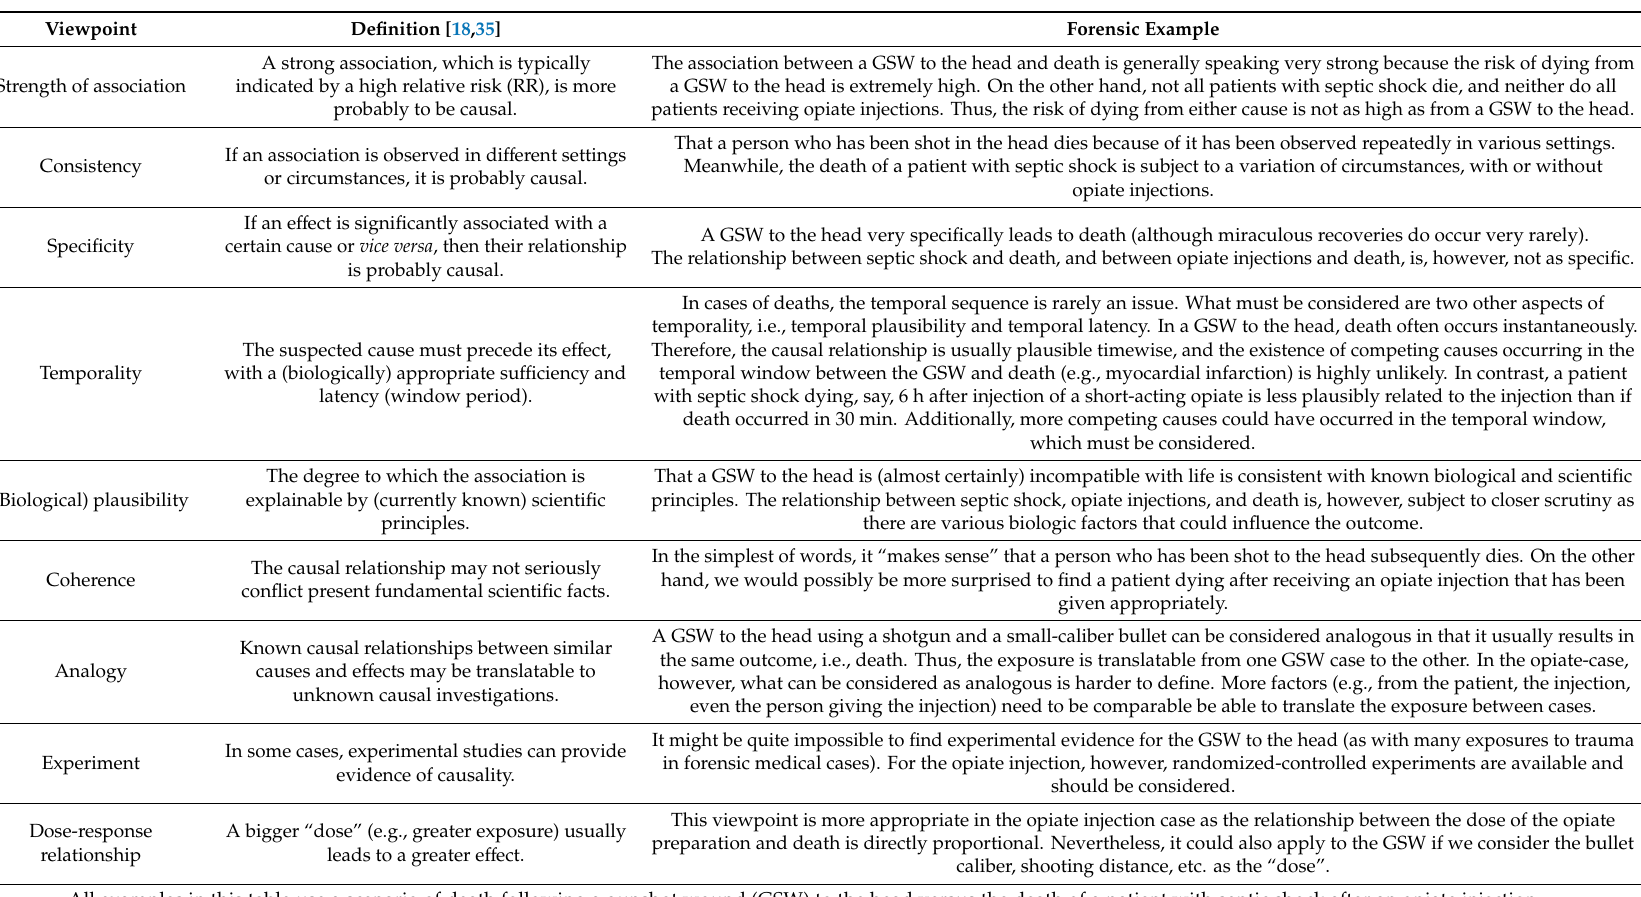
Table A2. Overview of Hill’s